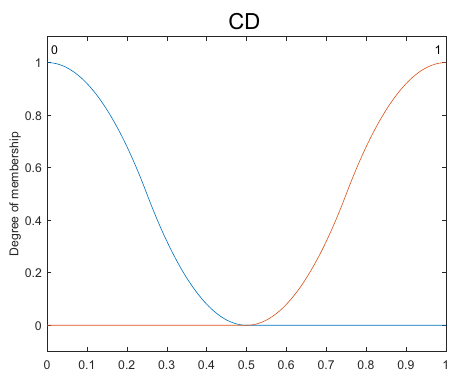
Figure 11. Inputs memberships functions of variable cooling demand (CD).